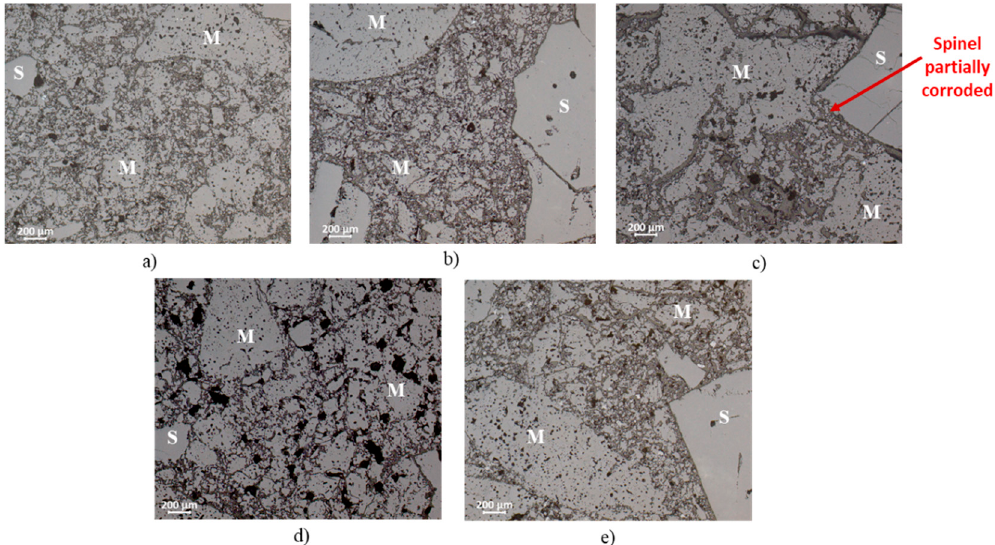
Figure 3. Microstructure of compositions ( a ) A-1, ( b ) A-2, ( c ) A-3, ( d ) A-4 and ( e ) A-5 (M = magnesia, S = fused spinel)—50× magnification.